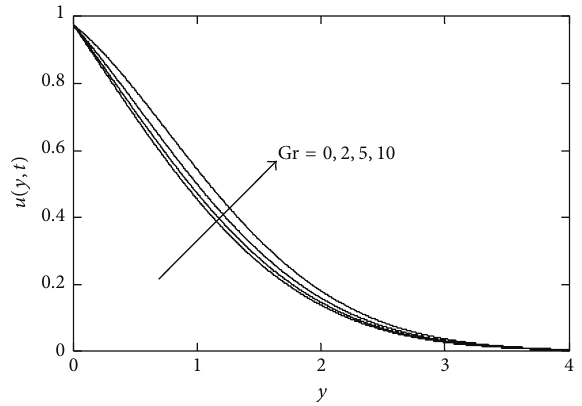
Figure 4: Profiles of velocity for different values of Gr, when Pr = 0.3 , 𝛾 = 0.6 , 𝑡 = 0.3 , and 𝜔 = 𝜋/4 .